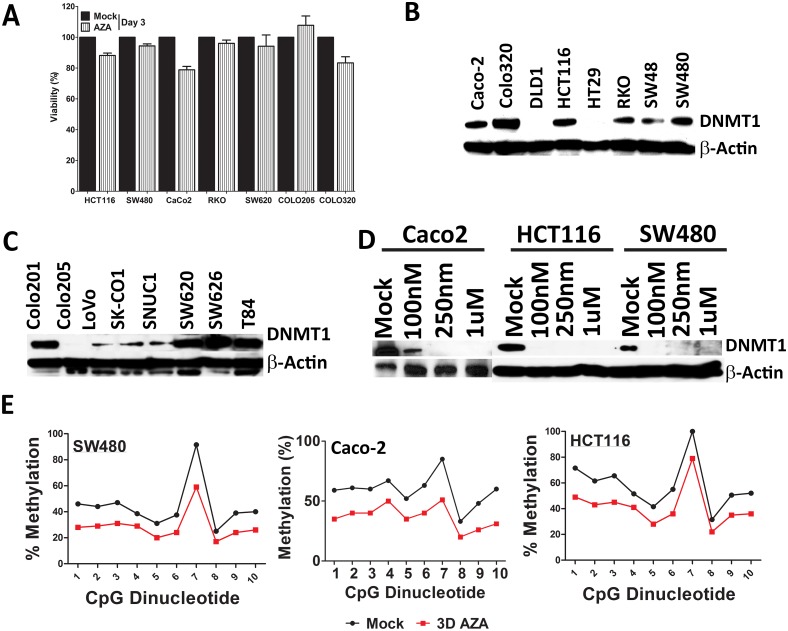
Low dose HMA causes global demethylation in CRC cell lines.(A) Colon cancer cell lines (HCT116, SW480, Caco-2, RKO, SW620, Colo205, Colo320) showed very little or no cytotoxicity. Percent viability after 72 hrs treatment with 500 nM AZA, relative to mock control. Bars represent the mean of 3 replicates ±SD; (B & C) Colon Cancer cell lines saw basal or low expression of DNMT1 protein. Upper and the lower panel is a representative blot for DNMT1 and β-Actin as a housekeeper. (D) Protein expression of DNMT1 in colon cancer cells (Caco-2-, HCT116 and SW480) changes after treatment with a various concentration of AZA. Cells were treated with AZA at the indicated concentrations for 72hr and then subjected to immunoblot analysis using anti-DNMT1 antibody. Actin served as a loading control. B, C, and D are representative blots of at least three independent experiments. (E) Quantitation of DNA methylation using bisulfite LINE-1 PCR and Pyrosequencing in Caco-2, SW480 and HCT116 (3-day treatment followed by 3 rest period). Representative LINE-1 quantitation presented for the cell lines. The pyrogram quantitates C for methylated, and T for unmethylated DNA was plotted as a line graph.